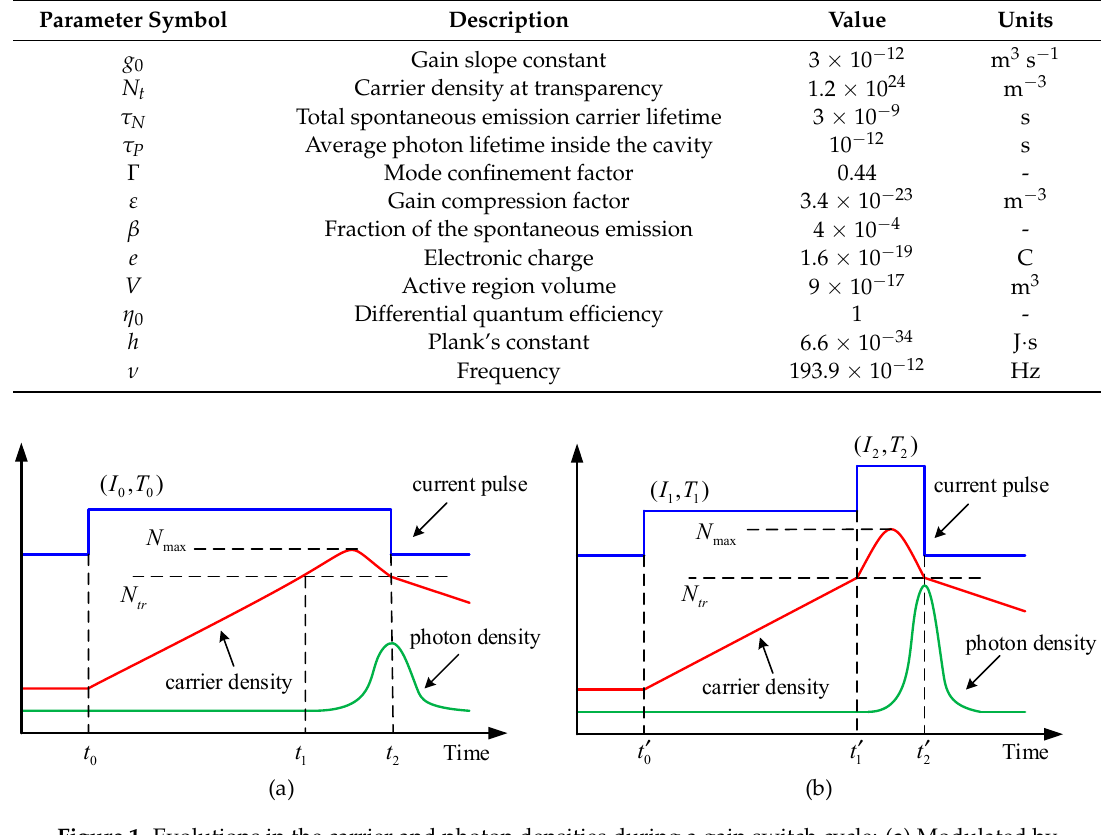
Table 1. Descriptions of parameters in Equations (1)–(3) and their values used in our numeral simulation. A dash (-) in the “Units” column means that the value is dimensionless.